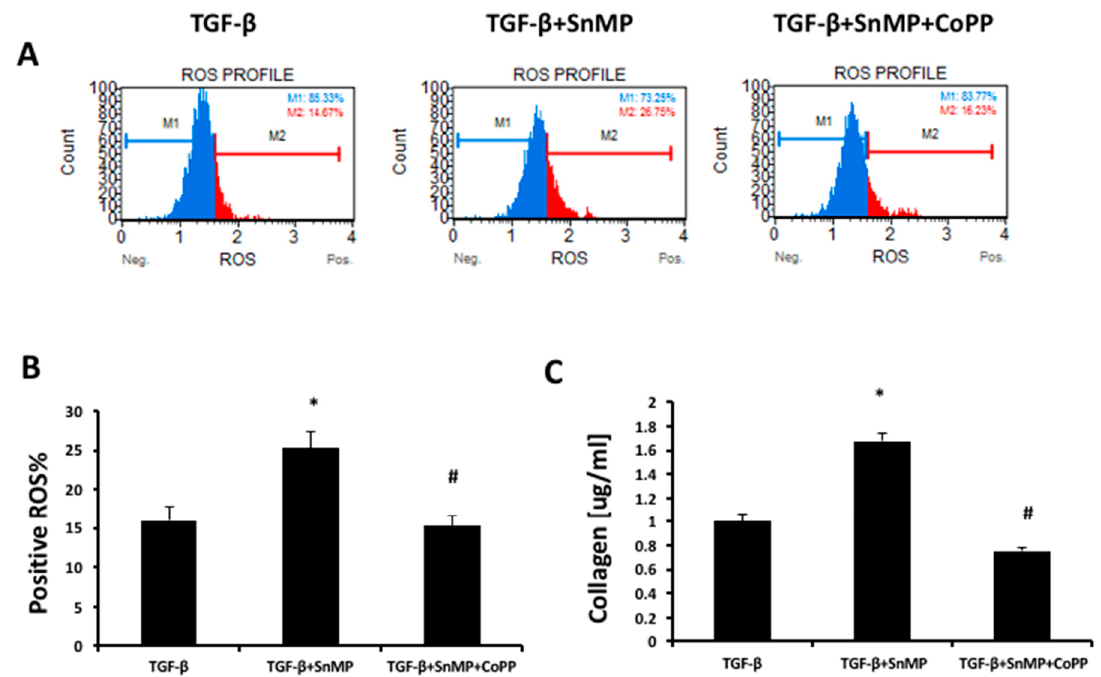
Figure 5. ( A ) The quantitative measurement of cells undergoing oxidative stress was evaluated by cytometry, using the Muse Oxidative Stress Kit. Cells were pre-treated with SnMP (5 µ M) and CoPP (5 µ M) for 24 h and then incubated for 1h with TGF- β 5 ng / mL. ( B ) The graph showed the positive ROS percentage in the di ff erent groups. * p < 0.05 vs. TGF- β , # p < 0.05 vs. TGF- β + SnMP. ( C ) Soluble collagen in LX2 cells treated with TGF- β 5 ng / mL for 24 h in the presence or absence of SnMP 5 µ M alone or in combination with CoPP 5 µ M. Soluble collagen measurement is expressed as µ g / mL. Values represent the means ± SD of three experiments performed in triplicate. * p < 0.05 vs. TGF- β ; # p < 0.05 vs. TGF- β + SnMP.